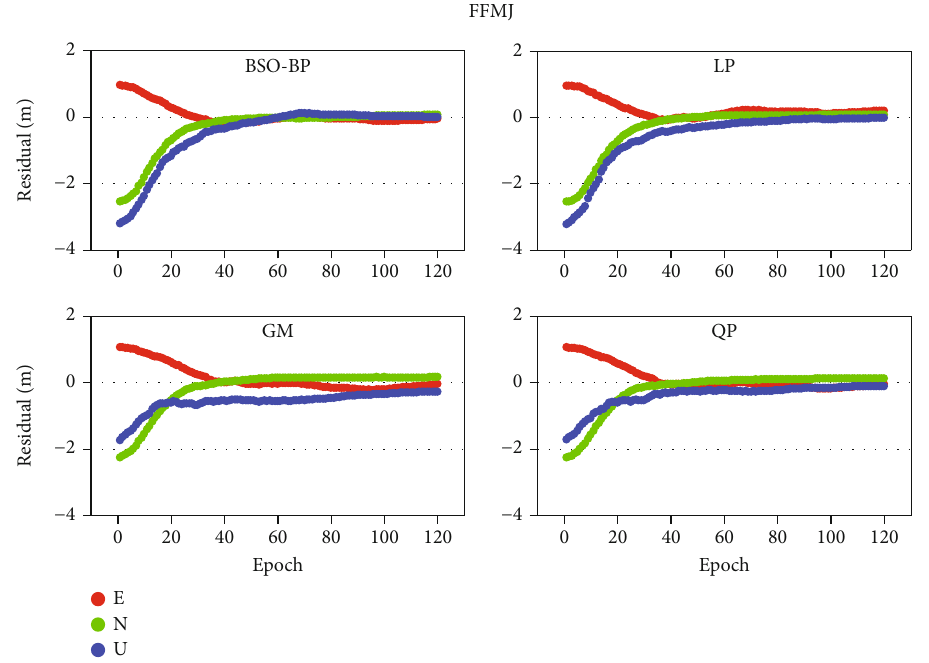
Figure 16: Residuals of the static PPP base on four clock model for FFMJ.